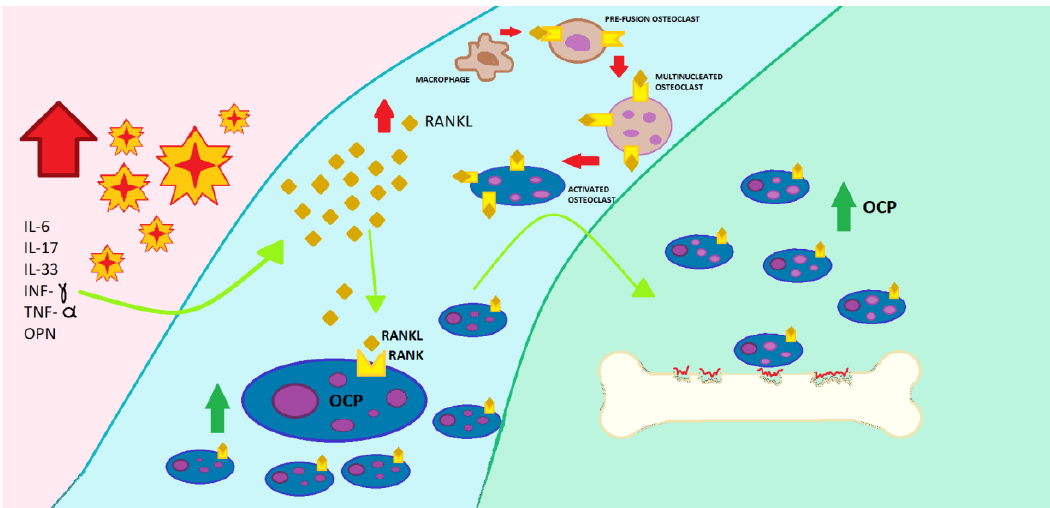
Figure 3. Role of inflammatory cytokines involved in psoriasis on bone remodeling. The increase in interleukin (IL)-6, IL-17, IL-33, interferon-gamma (INF- γ ), tumor necrosis factor (TNF)- α , and osteopontin (OPN) increases the secretion of RANKL, which promotes the differentiation of macrophages in pre-fusion osteoclasts, then in multinucleated osteoclasts, and finally in activated osteoclasts, increasing bone resorption.